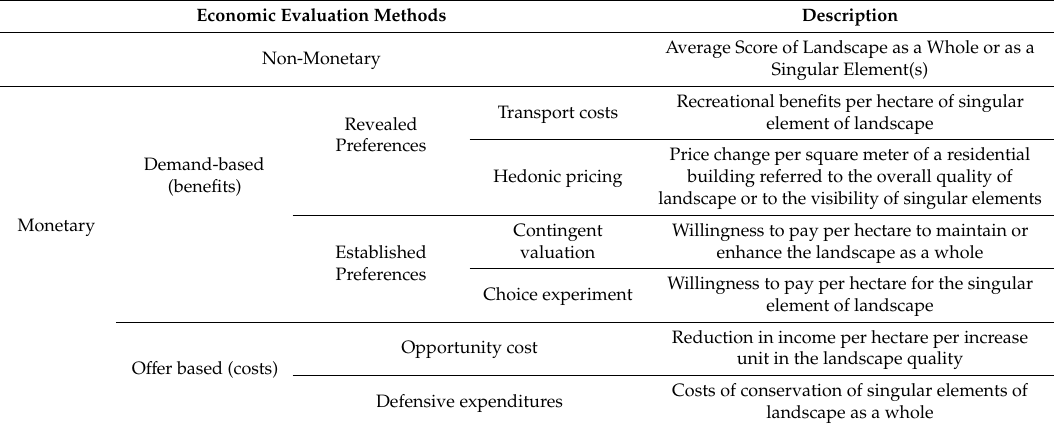
Table 1. Economic evaluation methodologies: Monetary and non-monetary approaches (elaboration from Marangon and Tempesta,